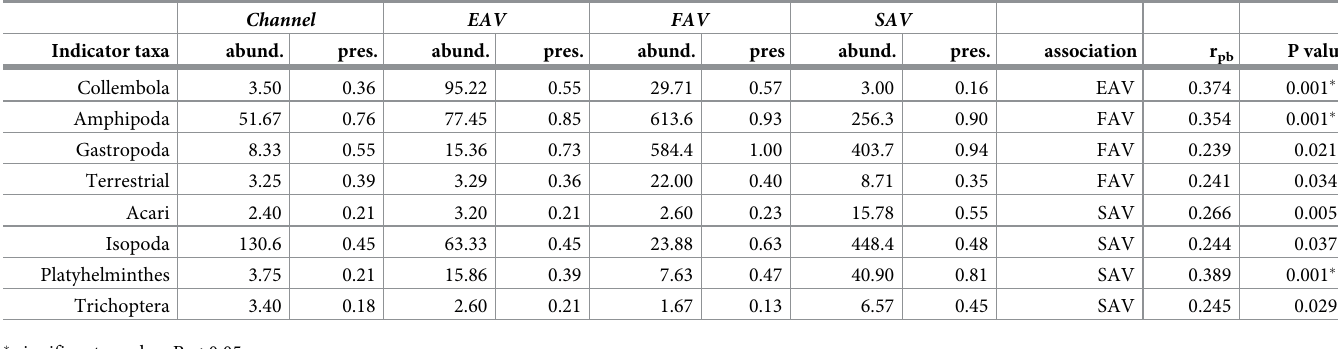
Table 8. Taxa which were significantly associated with a particular habitat, mean abundance by group (abund.), proportion of samples where taxa was present (pres.), and statistical significance of the association.